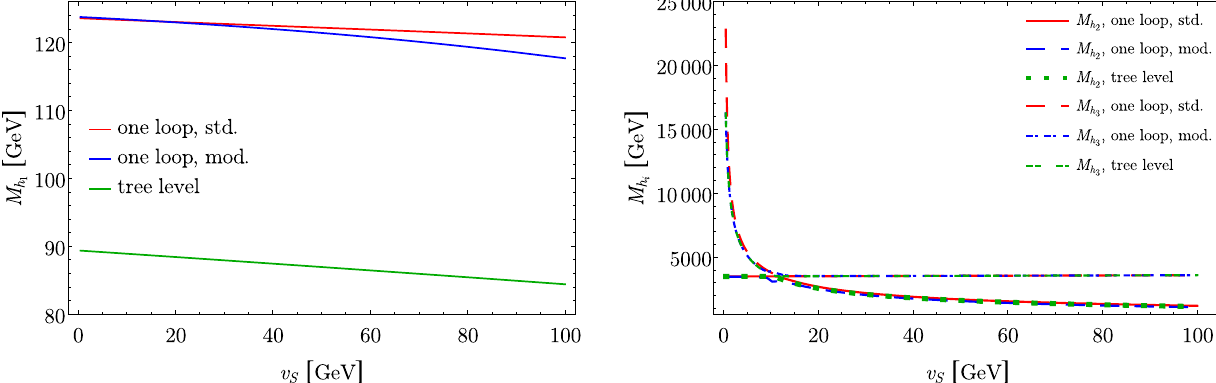
Fig. 11 M h (left) and M h and M h (right) as a function of v S , in scenario 2. Input values for the other BSM parameters are given in Table 1 2 3